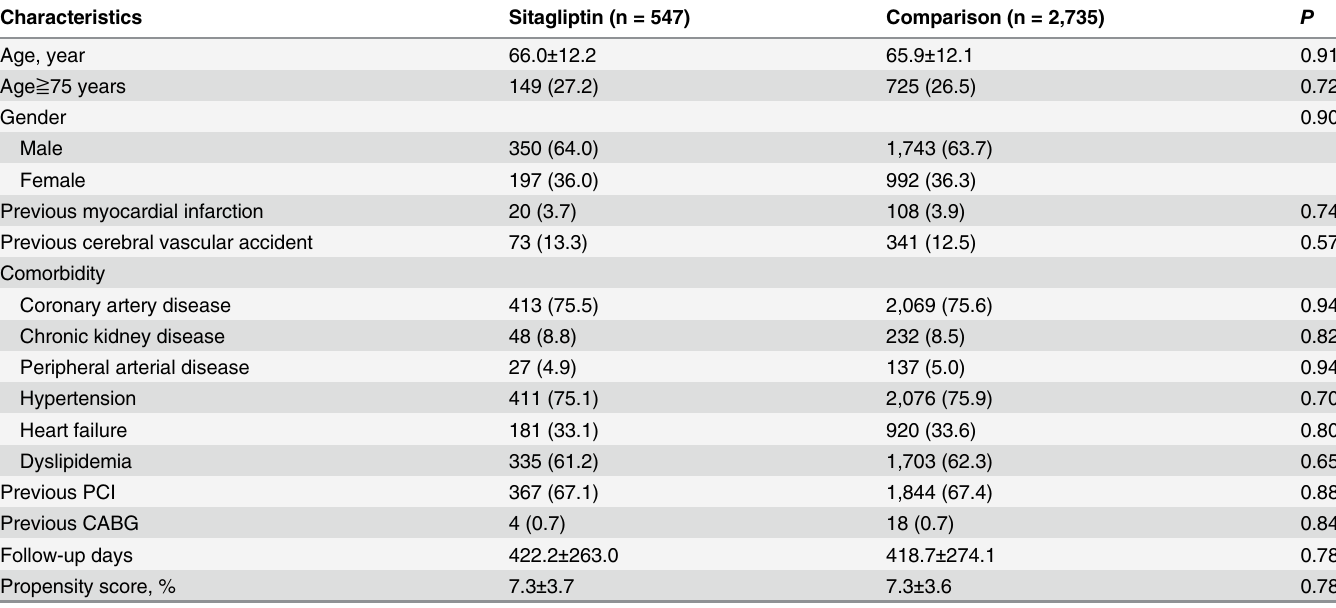
Table 1. Baseline clinical characteristics of the study